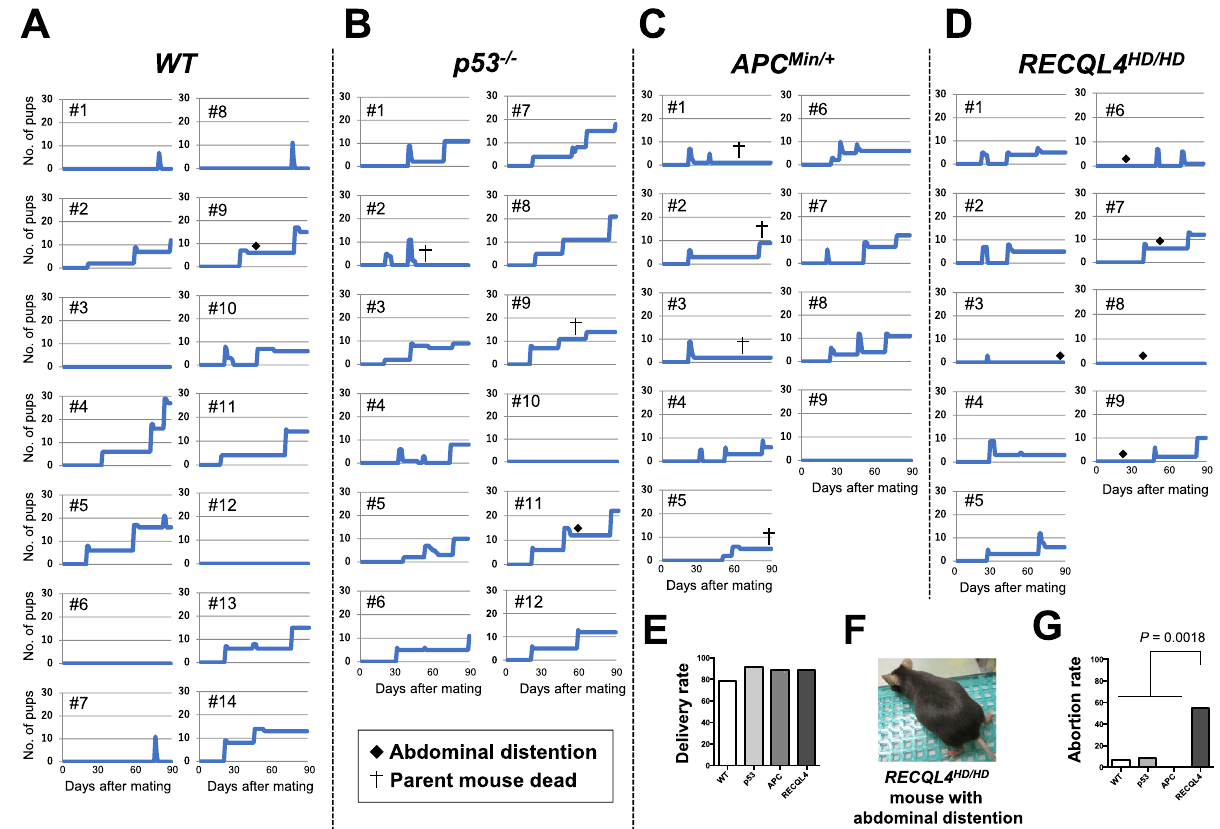
Figure 3. Cumulative pup numbers of each mating pair in the four strains within a 90-day period. Cumulative pup numbers produced by each mating pair of wild-type C57BL/6 N ( A ), p53 −/− ( B ), APC Min/+ ( C ), and RECQL4 HD/HD ( D ) mice. The diamonds indicate mice with abdominal distention. The crosses indicate the death of one parent mouse. ( E ) Delivery rates of the four mouse strains. ( F ) Representative image of a RECQL4 HD/HD mouse with abdominal distention. ( G ) Abortion rates of the four mouse strains. Ordinary one-way ANOVA for multiple comparisons among the four strains indicated a p value of 0.0018 between the RECQL4 HD/HD mice and the other mouse